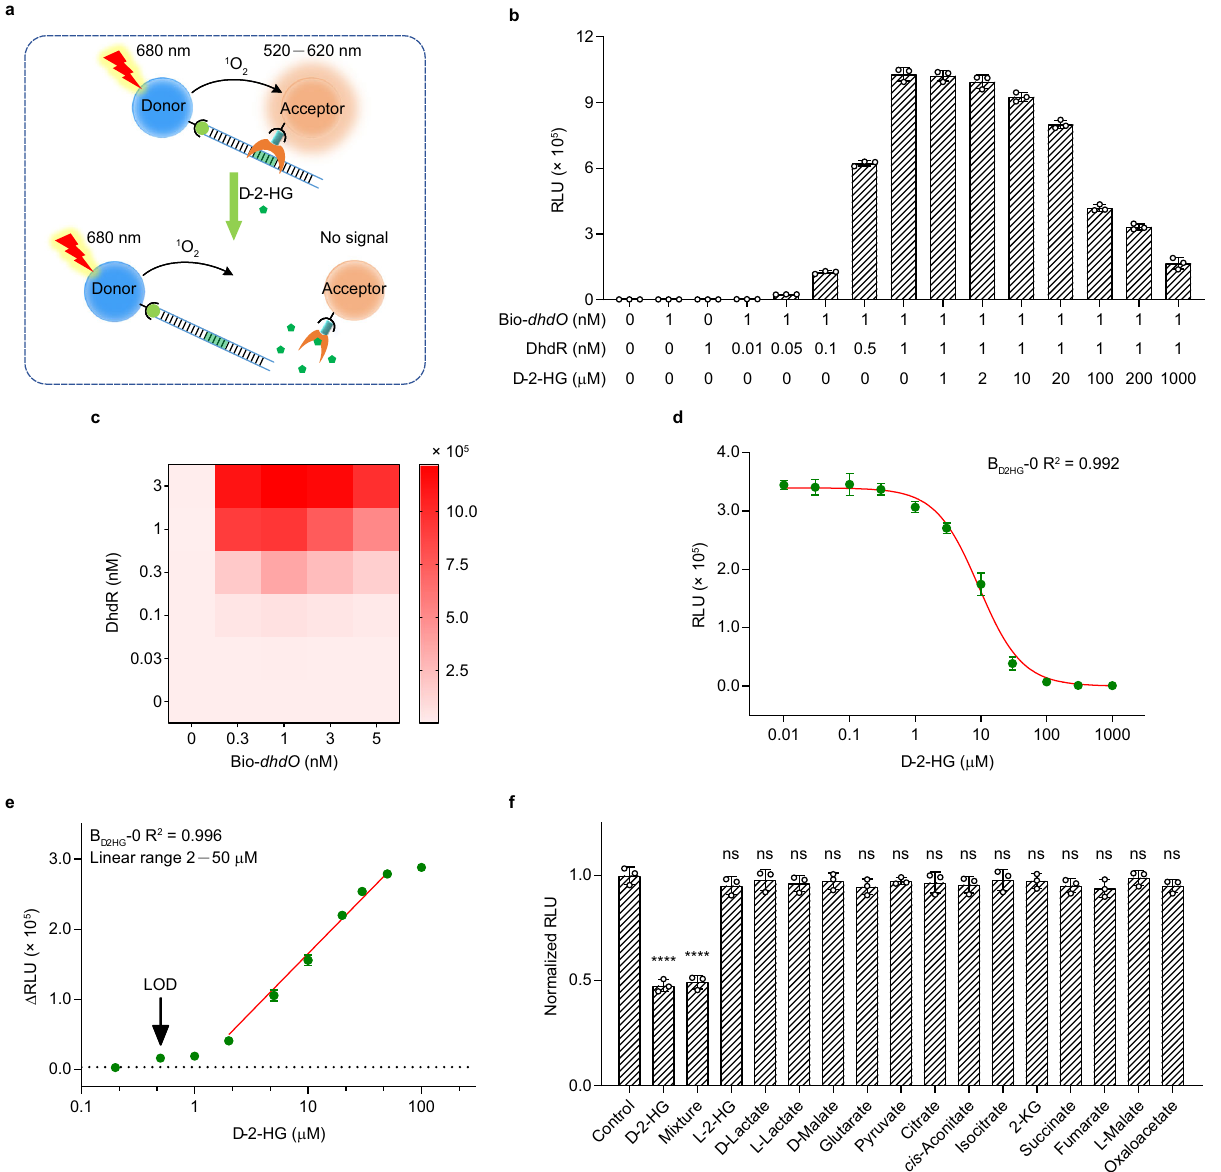
Fig. 3 Design of the D -2-HG biosensor (B ). a Schematic diagram of the biosensor based on DhdR and AlphaScreen. b Evaluation of allosteric effect of D 2HG D -2-HG on Bio- dhdO -DhdR interaction by AlphaScreen. Data shown are mean ± s.d. ( n = 3 independent experiments). c Determination of the optimal concentrations of DhdR and Bio- dhdO by cross-titration. Each heat map cell shows the average of the luminescence signals of each titration ( n = 3 independent experiments). d Response of B -0 to different concentrations of D -2-HG. e The linear detection range of B -0. Black dotted line is a D 2HG D 2HG reference line where the reduced luminescence signal ( Δ RLU) is three times of the background signal. f Speci fi city of B -0. The concentrations of tested D 2HG chemicals were 10 μ M. The column mixture contained 10 μ M D -2-HG and 10 μ M all other tested chemicals. The corresponding luminescence signals are normalized to the maximal value (luminescence signals of control) in the absence of D -2-HG. The concentrations of DhdR and Bio- dhdO in d – f were 0.3 and 1 nM, respectively. Data shown are mean ± s.d. ( n = 3 independent experiments). The signi fi cance was analyzed by a two-tailed, unpaired t -test. **** P < 0.0001; ns, no signi fi cant difference ( P ≥ 0.05). Exact P values are reported in the Source Data fi le. Source data are provided as a Source Data fi le. value of DhdR for DBS is too large. The S/N would reduce and clinical indicator of D -2-HG-related diseases 1,3,32 . Considering -1 for D -2-HG, small amounts of in fl uence the LOD of the biosensor due to the low af fi nity of the high sensitivity of B D 2HG -1 body fl uids are required for D -2-HG quantitation. Thus, the dose- DhdR for DBS. Among the fi ve optimized biosensors, B D 2HG exhibited the lowest LOD (0.10 μ M) and a wide linear range response curves of D -2-HG were determined in 100-fold diluted human serum or urine (Fig. 5a, b). Then, D -2-HG, at a range of (0.3 – 20 μ M) (Fig. 4a – f, Supplementary Fig. 14, and Supplemen- tary Table 4). Thus, this biosensor was selected for the concentrations, was spiked into human serum or urine and quanti fi cation of D -2-HG levels in subsequent experiments. quanti fi ed using B -1 and LC-MS/MS. The agreement D 2HG between the results from LC-MS/MS and the D -2-HG biosensor was satisfactory (Fig. 5c, d). 2-KG, L -glutamate, L -glutamine, and Performance of B -1 in D -2-HG quantitation . The con- D 2HG isocitrate are possible precursors of D -2-HG in vivo. Therefore, centration of D -2-HG in body fl uids may potentially be used as a NATURE COMMUNICATIONS| (2021) 12:7108